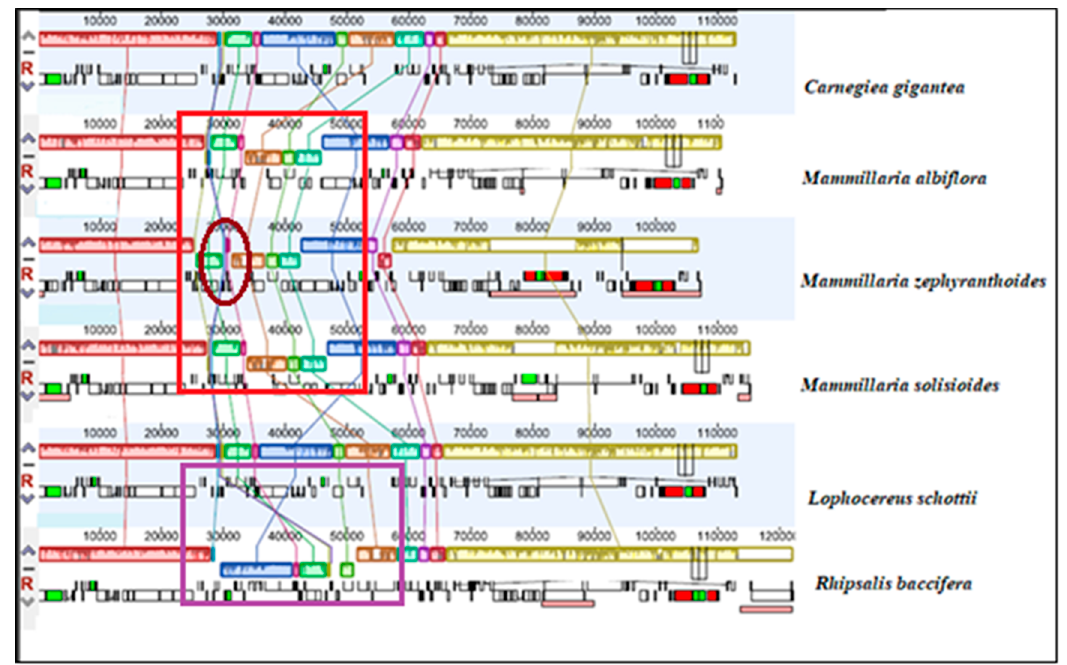
Figure 9. Genome structural alignment map of six chloroplast genomes of species in family Cactaceae, with Rhipsalis baccifera as the reference species aligned using MAUVE software. Local collinear blocks within each alignment are represented as blocks of similar color connected with lines. Annotations of rRNA , protein coding and tRNA genes are shown in red, white, and green boxes, respectively .